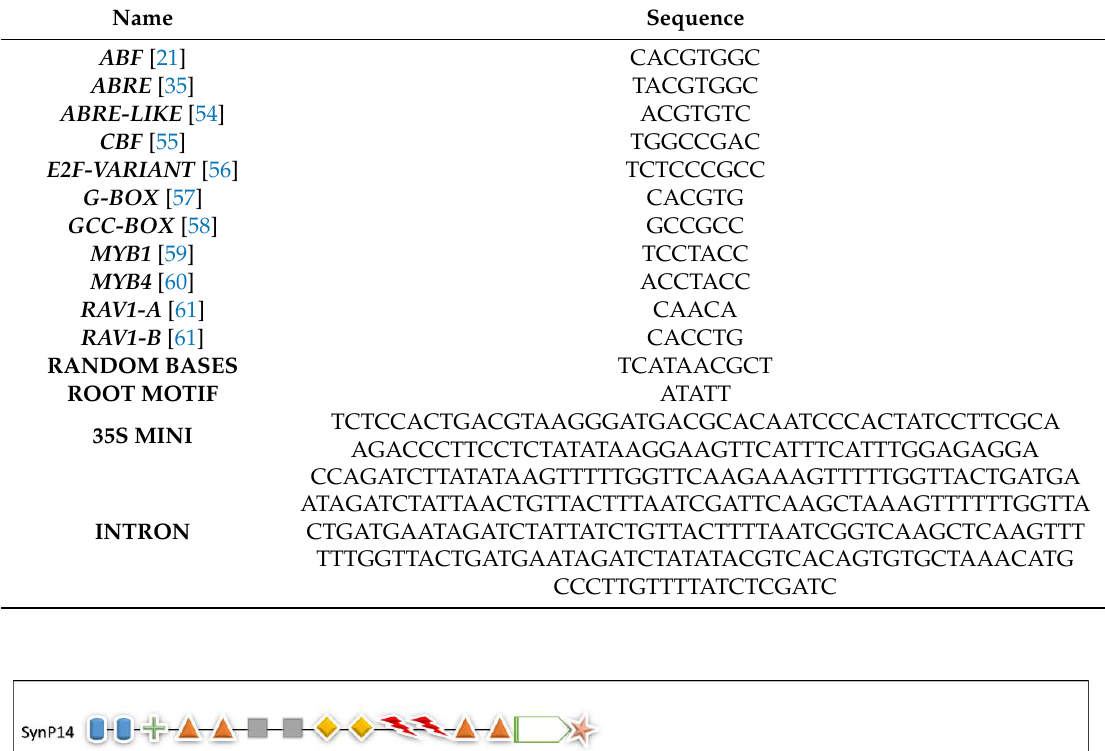
Table 1. Elements and their sequences used in construction of synthetic promoters. The intron is of GmEF-1a (elongation factor-1a) gene from soybean.